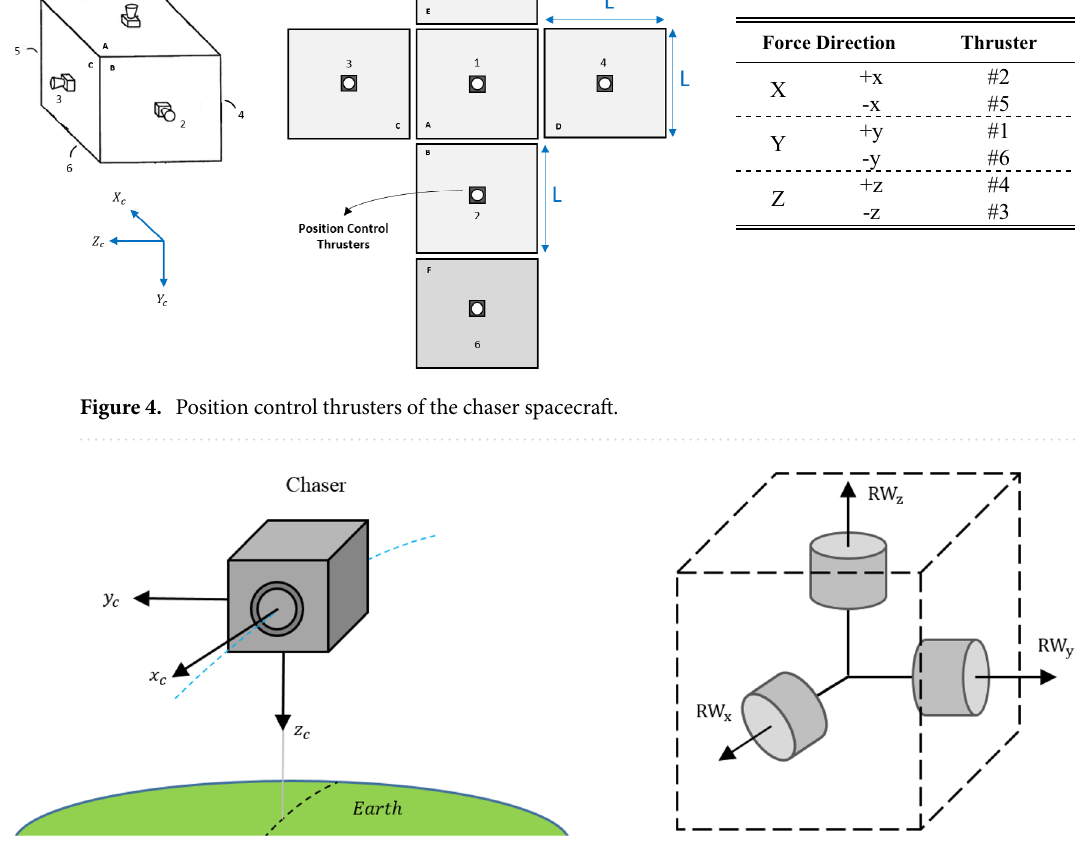
Figure 5. Reaction wheels of the chaser